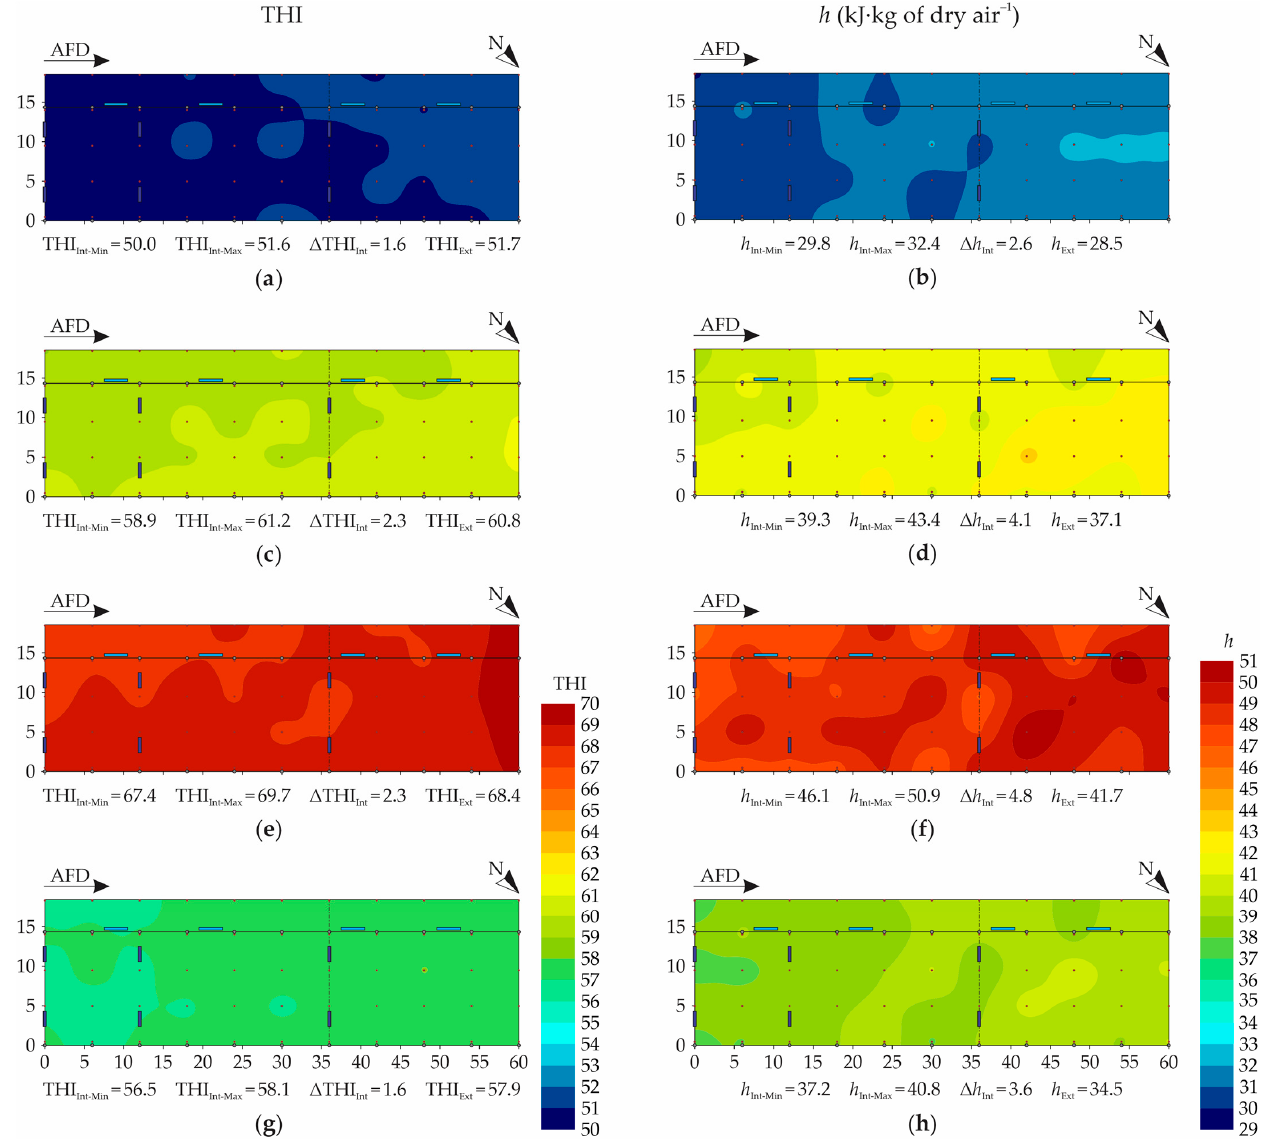
Figure 6. Spatial distribution of temperature and humidity index (THI) and specific enthalpy of air